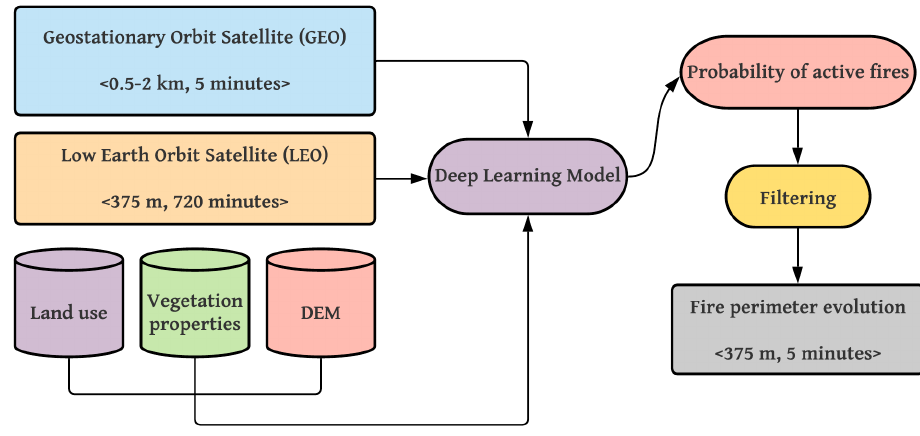
Figure 1. Block diagram of the statistical downscaling framework used for high-resolution continuous monitoring of active wildland